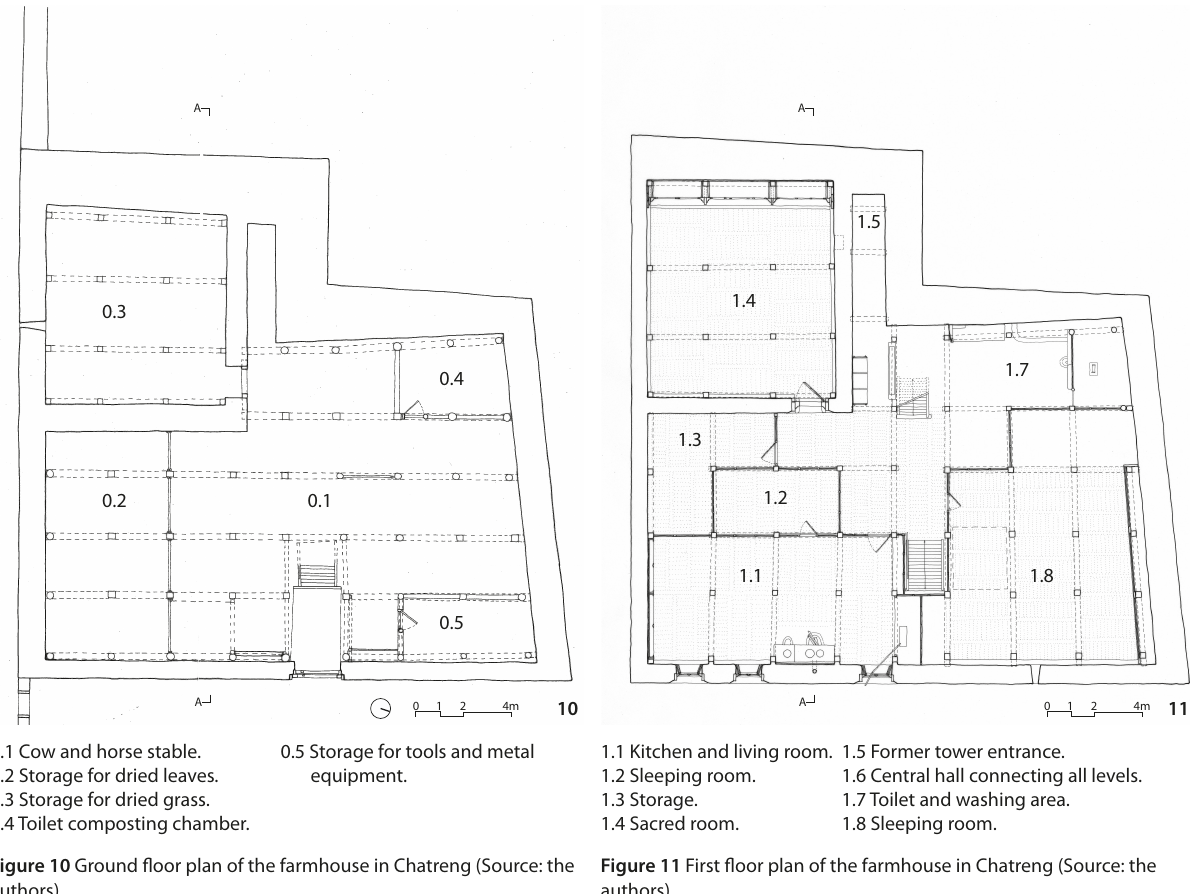
Figure 11 First floor plan of the farmhouse in Chatreng (Source: the authors).